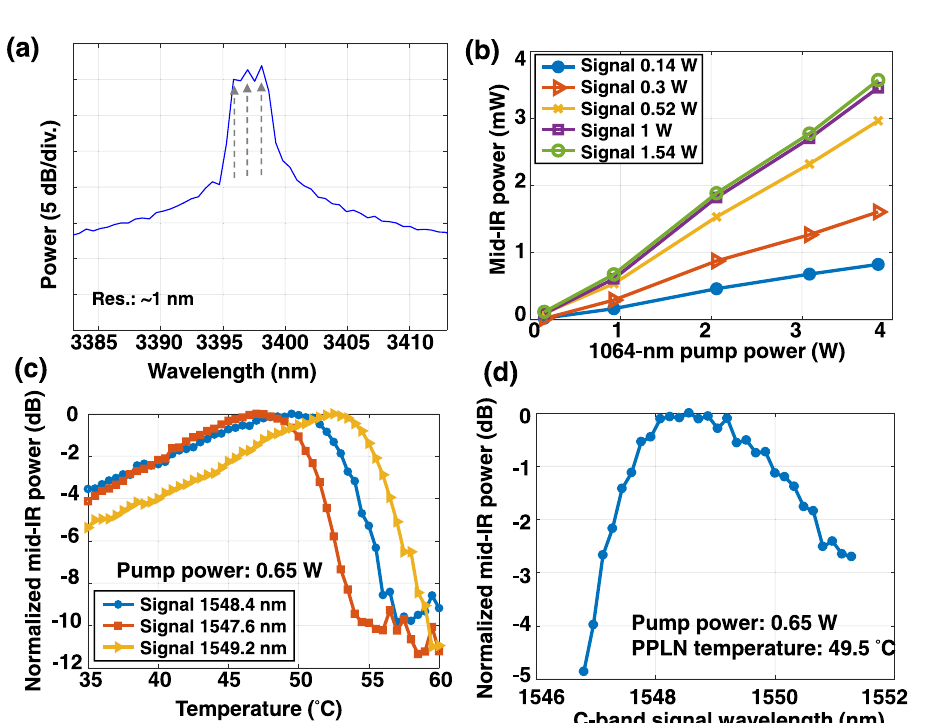
Fig. 3 | The generation of mid-IR WDM signals through the difference- frequencygenerationprocessintheperiodicallypoledlithiumniobate(PPLN) waveguide. a Spectrum of the generated mid-IR WDM signals with a resolution of ~1nm. Arrows indicate the three mid-IR WDM channels. b Generated mid-IR beam powerasafunctionofthe1064nmpumppowerwithdifferentsignalpowervalues.